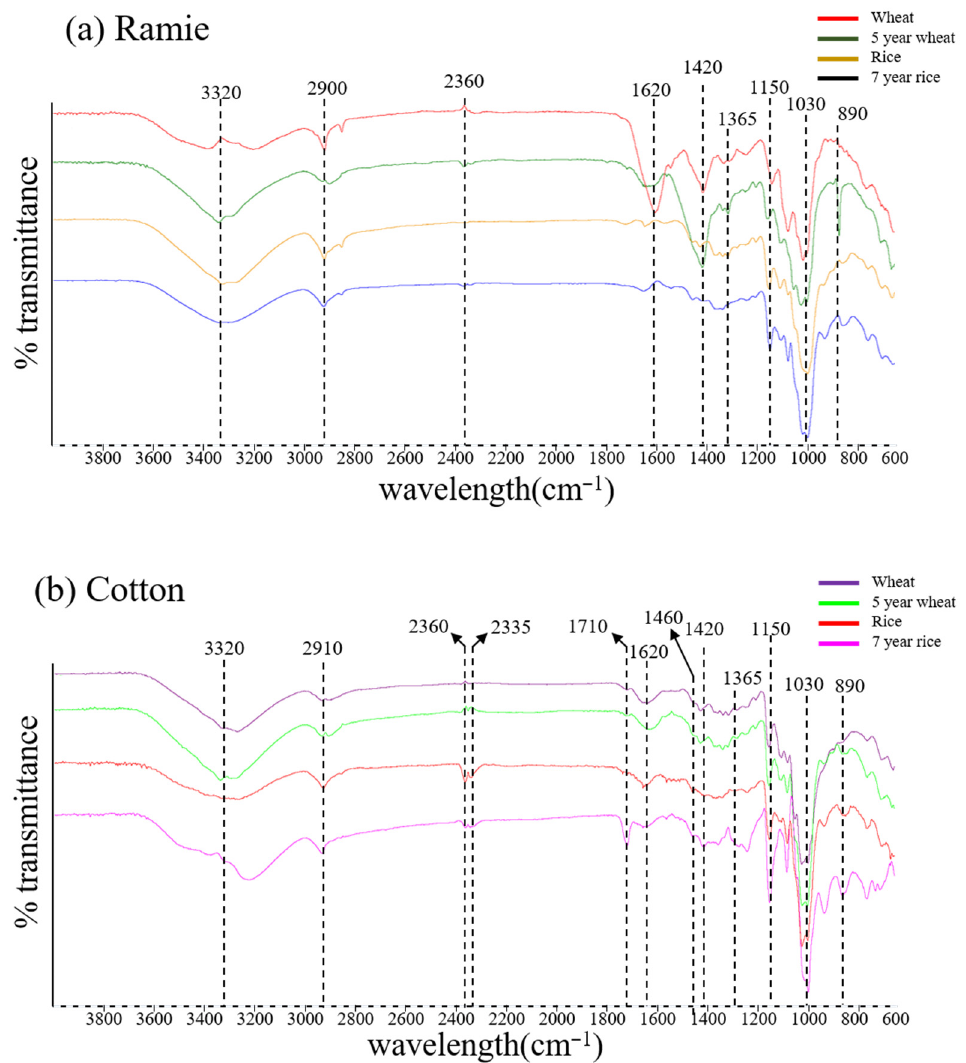
Figure 5. FT-IR spectrums of ( a ) Ramie ( b ) Cotton fabrics coated with fresh wheat starch, 5-year fermented wheat starch, fresh rice starch, and 7-year fermented rice.